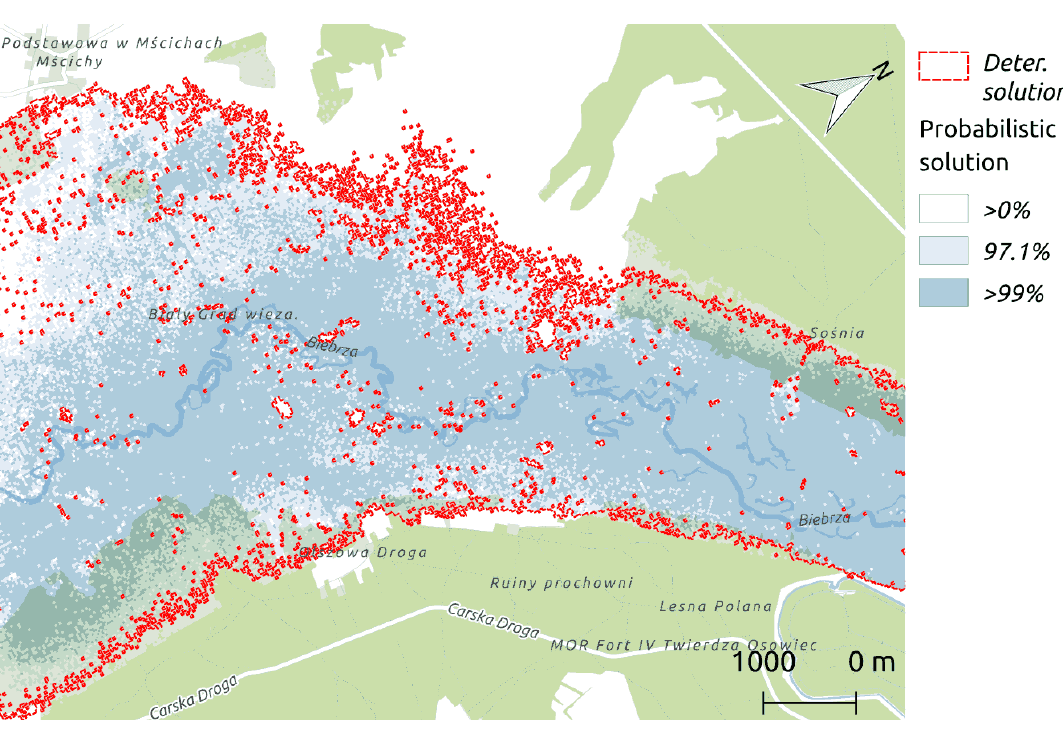
Figure 5. Probability map of inundation extent as the result of correlated DTM uncertainty; the red dashed line indicate the solution neglecting the DTM uncertainty; base map was developed using OpenStreetMap layers [59].